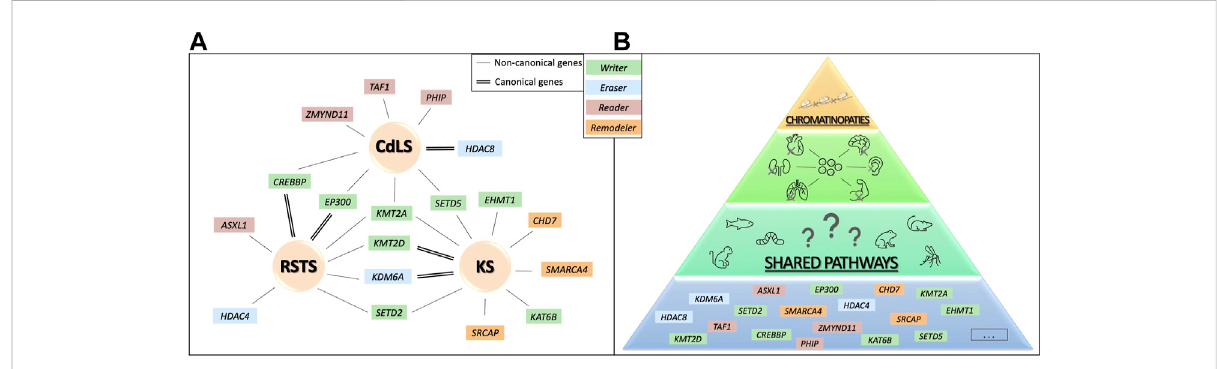
FIGURE 2 Genetic convergencefordifferenthumanphenotype.In (A) ,canonical andnon-canonical causativegenesareshownforRSTS,CdLSandKS.In (B) a schematic representation of the hypothesis of possible shared molecular pathways upon chromatin balance disruption resulting in organ abnormal development that could be studied combining animal models and human